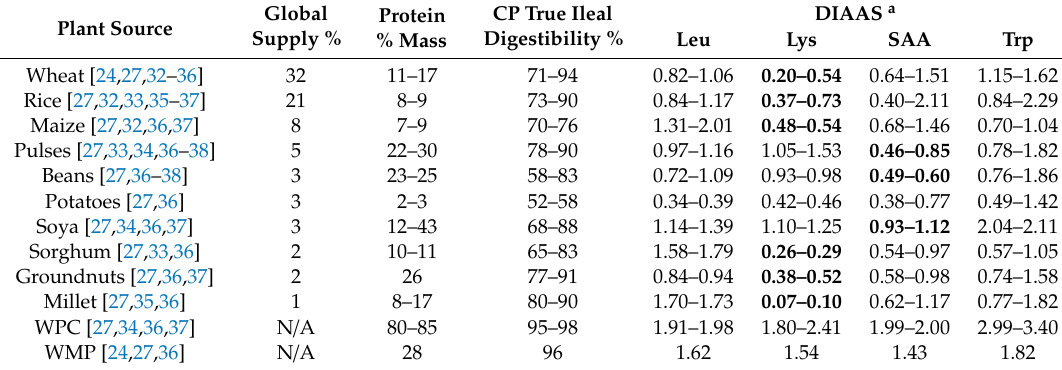
Table 1. Global plant protein supply (% total plant protein intake), digestibility and digestible indispensable amino acid score (DIAAS) range. CP, crude protein; whey protein concentrate (WPC) and whole milk powder (WMP) are provided as animal protein references. Leu, leucine; Lys, lysine; SAA, sulphur amino acids (methionine and cysteine); Trp, tryptophan. First limiting amino acid is in bold. a World Health Organisation (WHO) / Food and Agriculture Organisation (FAO) / United Nations University (UNU) adult indispensable amino acid (IAA) reference pattern as mg IAA · g protein − 1 (Leu, 66; Lys, 57; SAA, 27; Trp, 8.5)